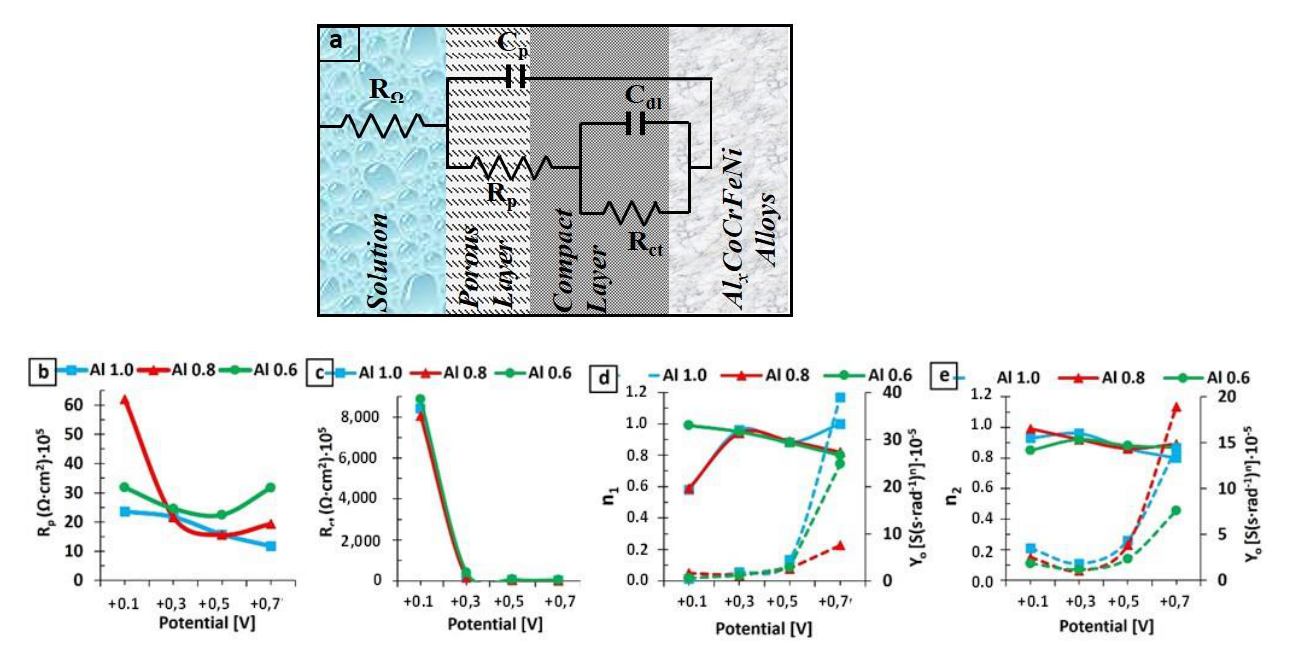
Figure 8. ( a ) Equivalent circuit with two time constants used for the fitting of spectra at positive potentials; ( b ) R p evolution